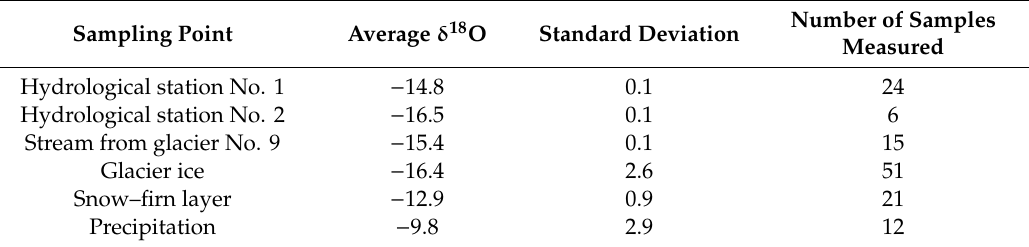
Table 2. Average isotopic composition of di ff erent groups of